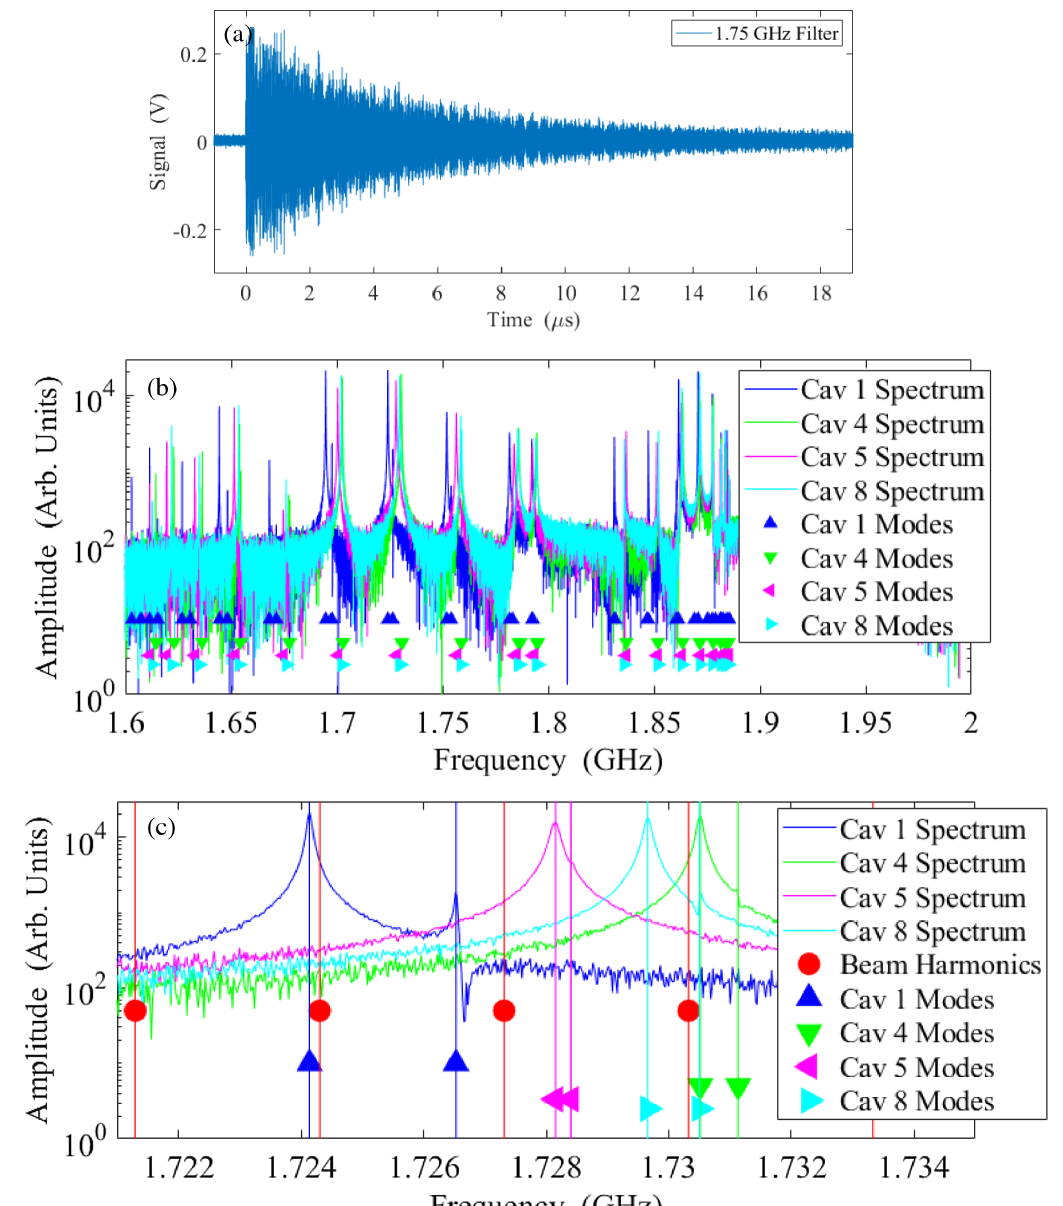
FIG. 12. (a) HOM signals after 1.75-GHz passband filter from cavity 1 of CM2. (b) Spectra of four cavities ’ 18 modes in CM2. (c) Dipolar mode-7 frequencies can vary by up to several MHz in the four sampled cavities of the CM, and the C1 (blue) and C4 (green) cavities have near resonances with the beam harmonics (red